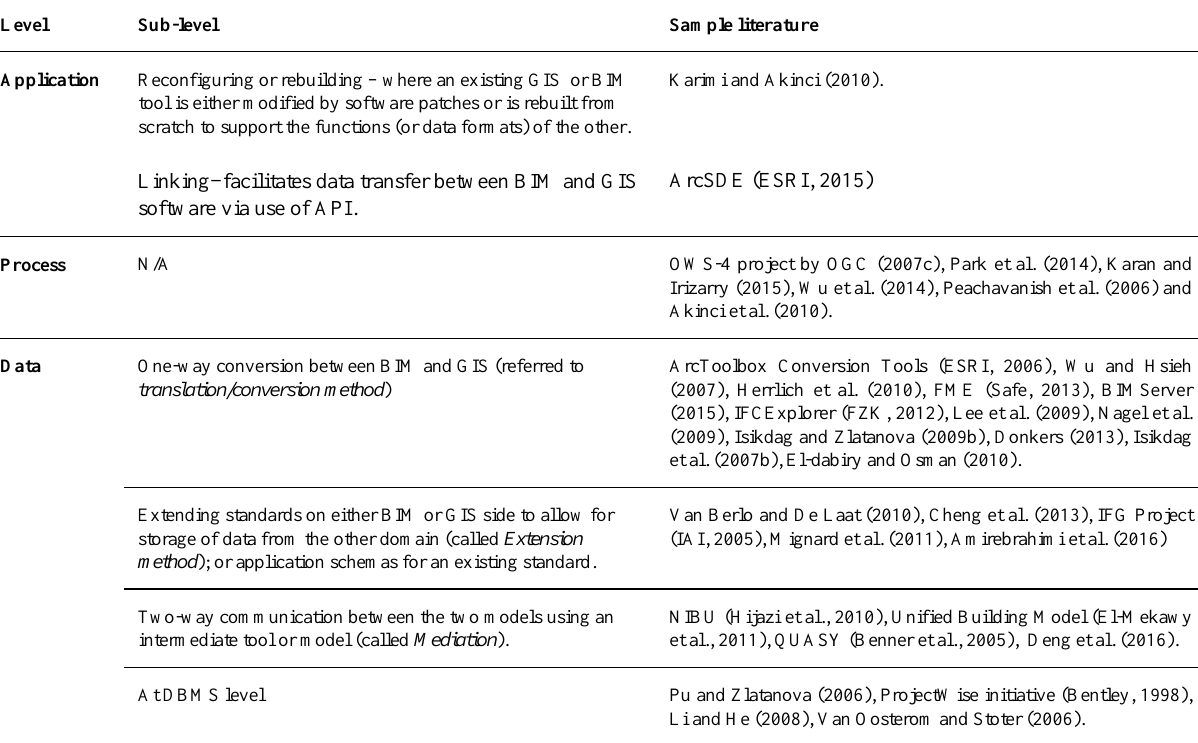
Table 1: Summary of BIM-GIS Integration